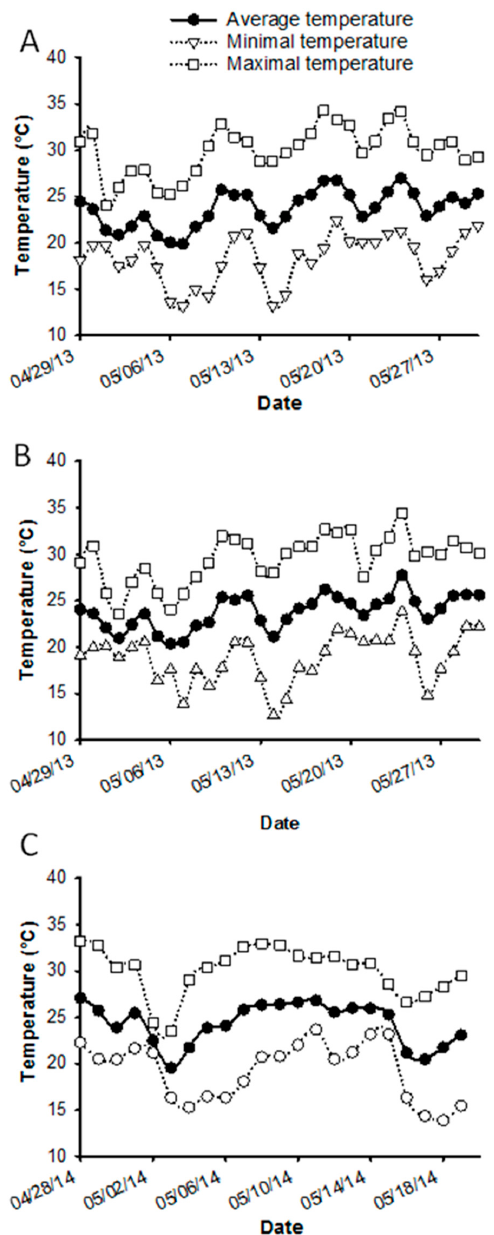
Figure 2. Average, minimal, and maximal temperatures recorded in Lake Alfred, FL during examination of dispenser release rates in 2013 ( A ); in Winter Garden, FL during 2013 ( B ) and 2014 ( C ) field trials of fir oil as a repellent for D. citri . field trials of fir oil as a repellent for D. citri